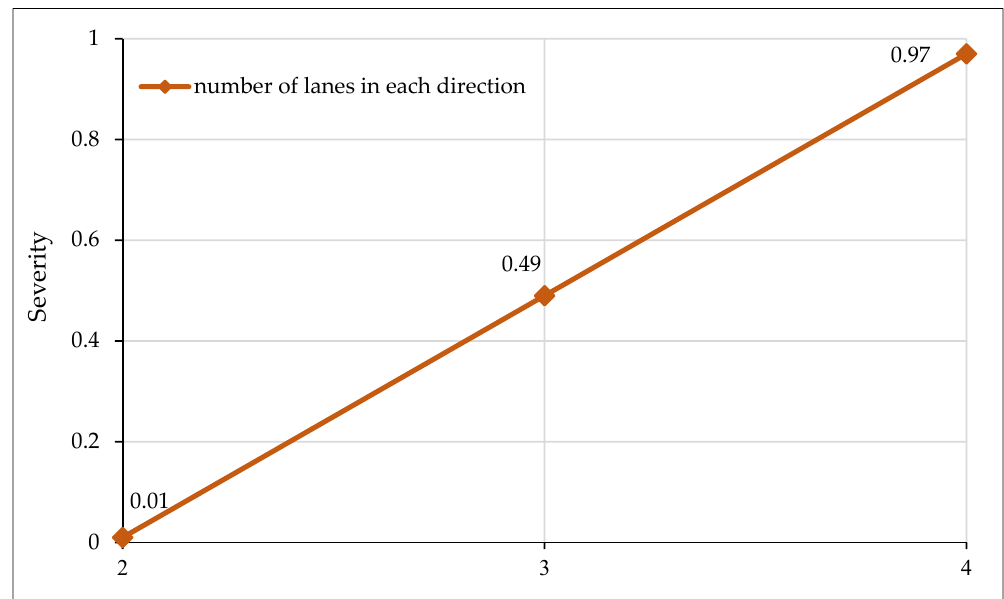
Figure 4. Effect of number of lanes in each direction on crash severity. Figure 4. E ff ect of number of lanes in each direction on crash